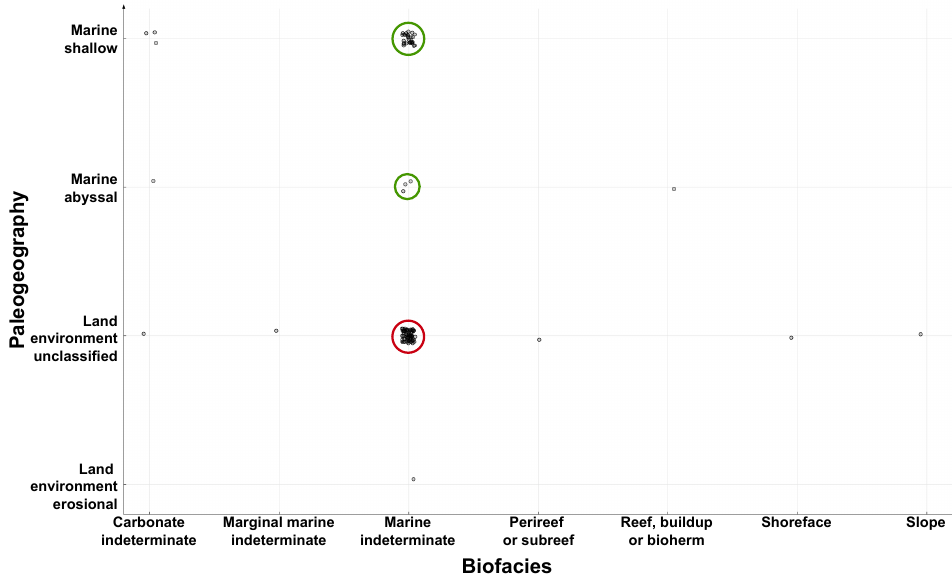
Fig. 7. Biofacies and paleogeographic associations at 402Ma (Early Devonian, Emsian times) highlight the discordance between the marine setting indicated by the fossil collections and the Australian paleogeography at this time (red circles). Agreement between the paleogeo- graphic model and fossil assemblages is also indicated (green circles). The fossil collections, as the seed points, were used to extract the paleogeography to create a time series for the purposes of data